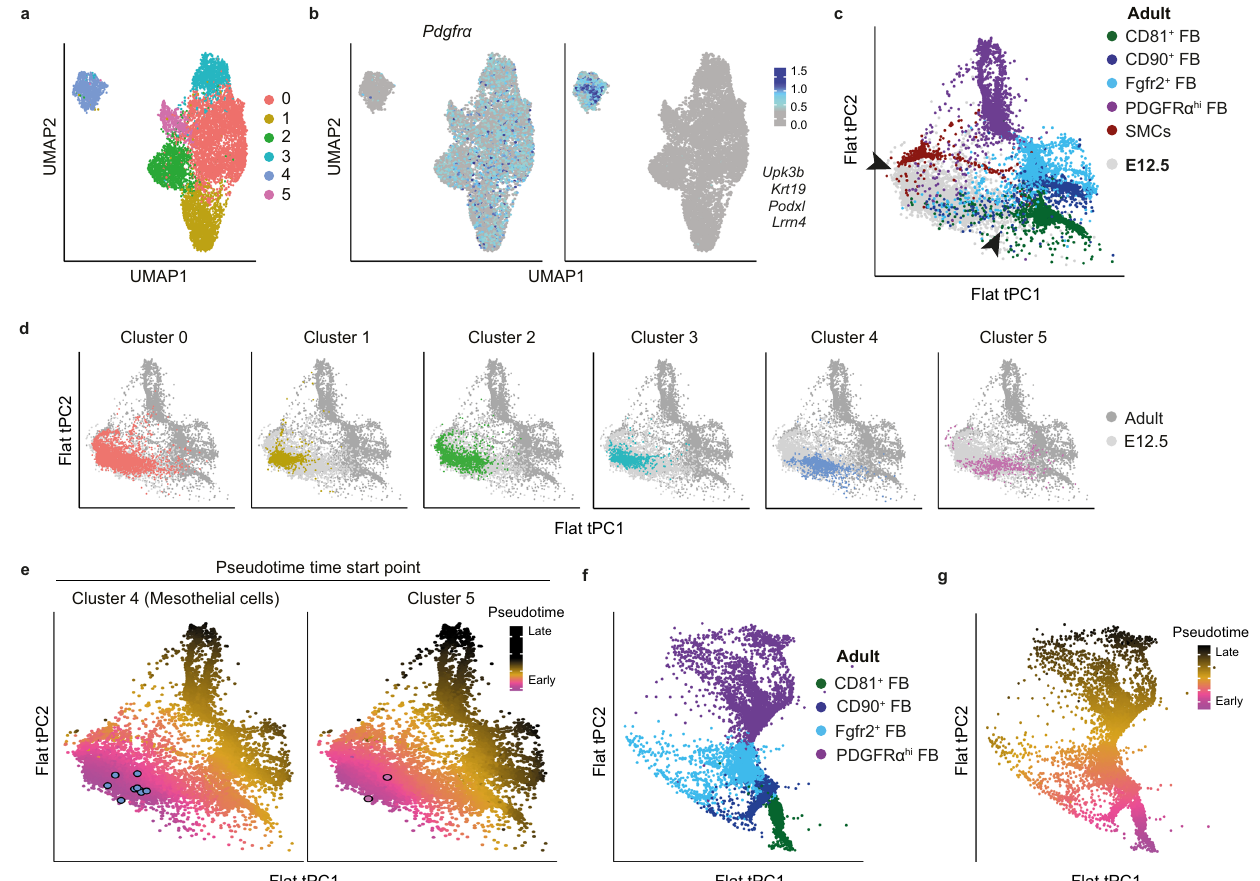
Fig. 5| Trajectory analysisindicatesthatadultintestinalFB subsetsdevelopin a linear fashion from embryonic Gli1 + precursors. a UMAP dimensionality reduction of scRNA-seq data colored by Louvain clustering from FACS puri fi ed Itg β 1 + MSC from the colon of embryonic dayE12.5 mice. Data are from 9632 single cells from 2 pooled experiments using 3 – 5 embryonic colons/experiment, with an averageof2521genes/cell. b UMAPofE12.5largeintestinalItg β 1 + MSCoverlaidwith expression of Pdgfra or the indicated mesothelium associated genes. c , d tSPACE principalcomponentanalysis(tPC1 – 3)projectionofpooledadultcolonicandE12.5 large intestinal MSC embedded into 2D space. c Adult clusters are color coded as indicated, while E12.5 clusters are in gray. Arrow heads indicate connections